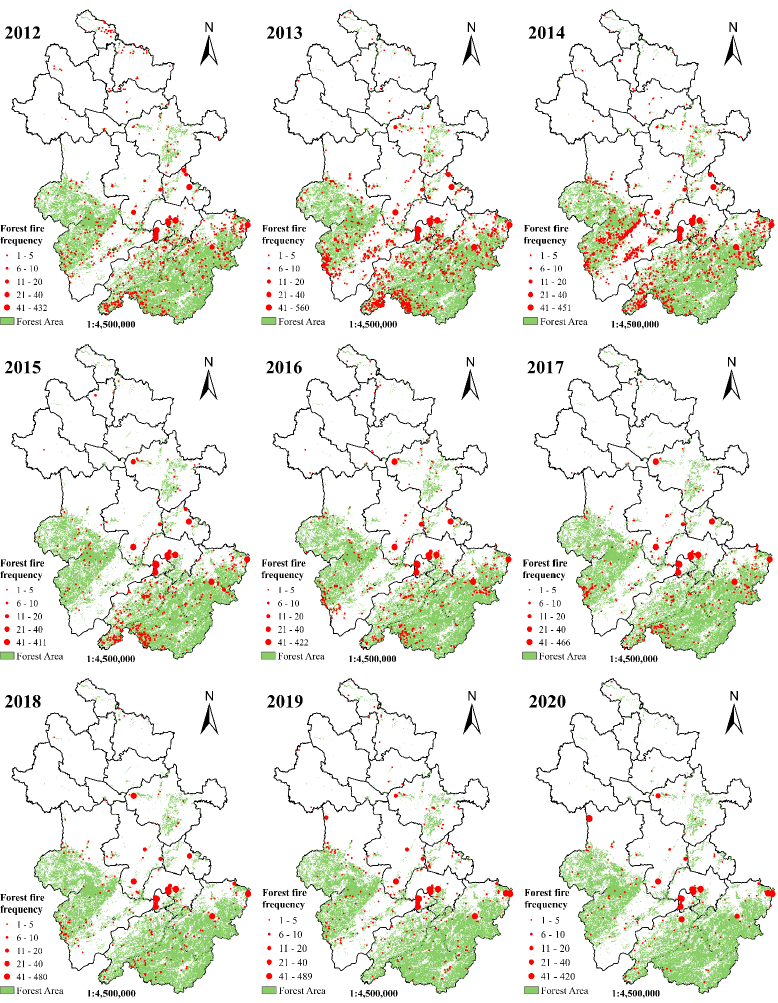
Figure 3. Spatial distribution of forest fire points in Anhui during 2012 – 2020.